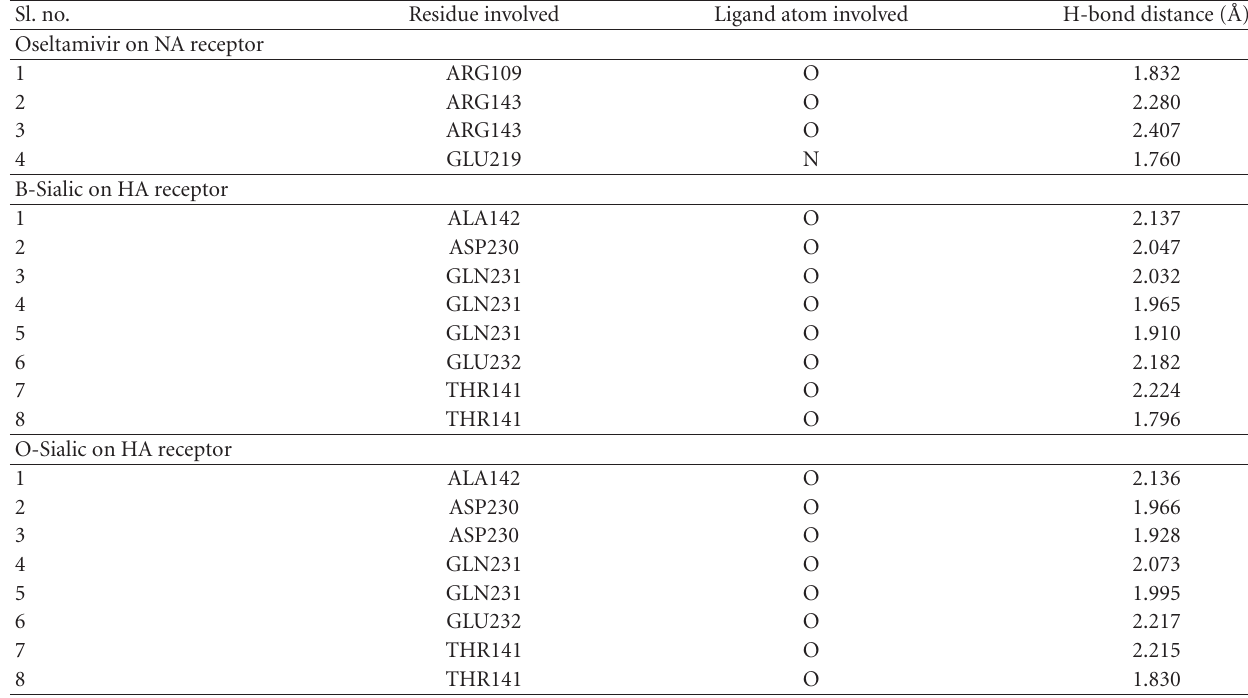
Table 3: Hydrogen-bond interaction parameters for each compound with NA and HA receptors.